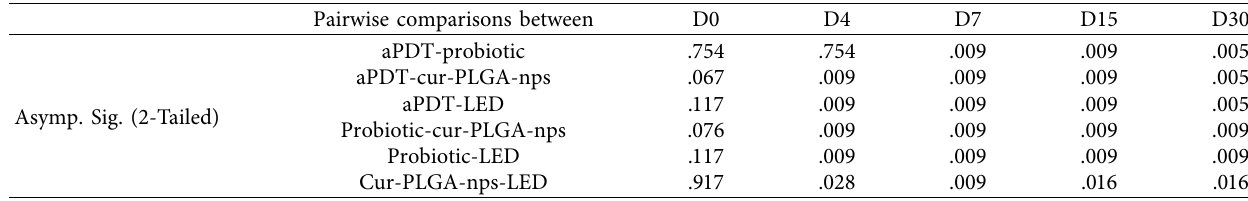
Table 5: Results from pairwise comparisons of CFU/mL of S. mutans between treatment groups with each other at each of the intervals, based on the Mann–Whitney test. Pairwise comparisons between D0 D4 D7 D15 D30 aPDT-probiotic .754 Asymp. Sig. (2-Tailed) Probiotic-LED .117